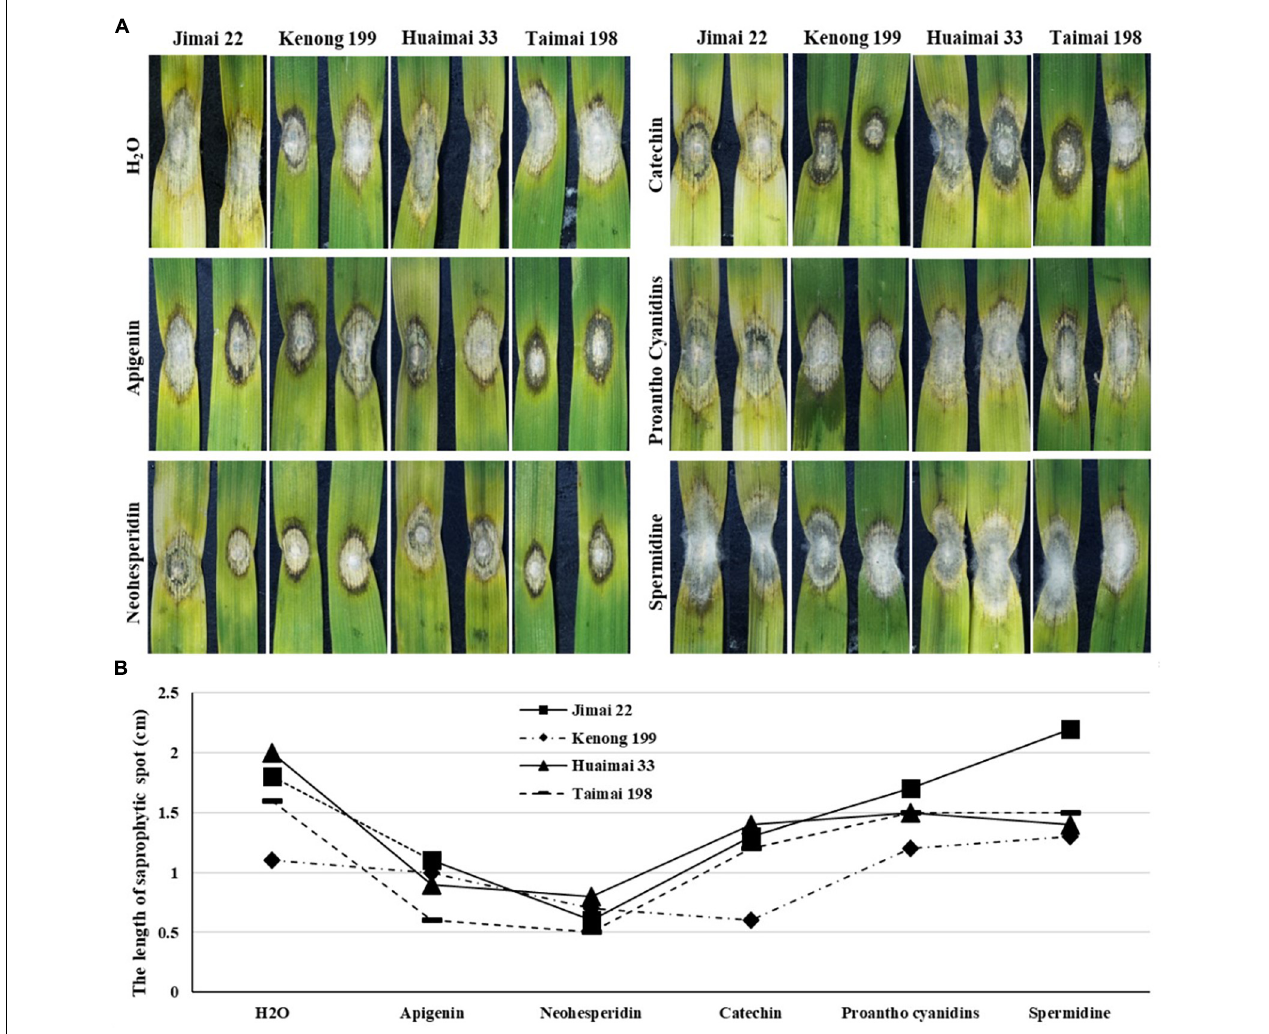
FIGURE 3 | Response to F. graminearum PH1-1 infection to exogenous metabolite treatments on the detached leaves of four different wheat cultivars (Jimai 22, Kenong 199, Huaimai 33, and Taimai 198) at 4 DAI. (A) Detached wheat leaves were treated with H 2 O, 50 µ M of apigenin, neohesperidin, catechin, proanthocyanidins, and spermidine after F . graminearum inoculation, respectively. (B) Length of the saprophytic spots on the detached leaves of Jimai 22, Kenong 199, Huaimai 33, and Taimai 198 at 4 DAI treated with H 2 O and 50 µ M of apigenin, neohesperidin, catechin, proanthocyanidins, and spermidine, respectively. Each replicate comprised at least 20 detached